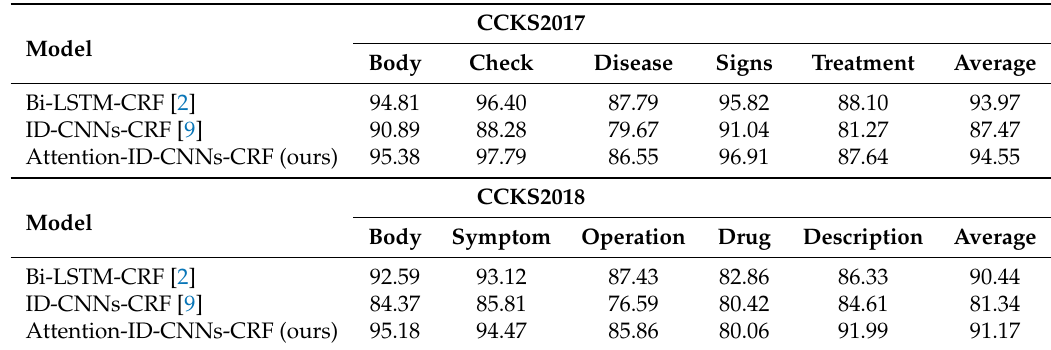
Table 6. Comparison of the entity category on the CCKS2017 and CCKS2018